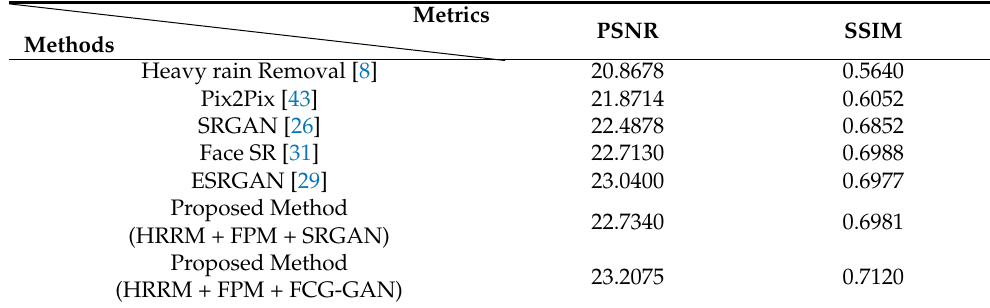
Table 2. Performance evaluation.